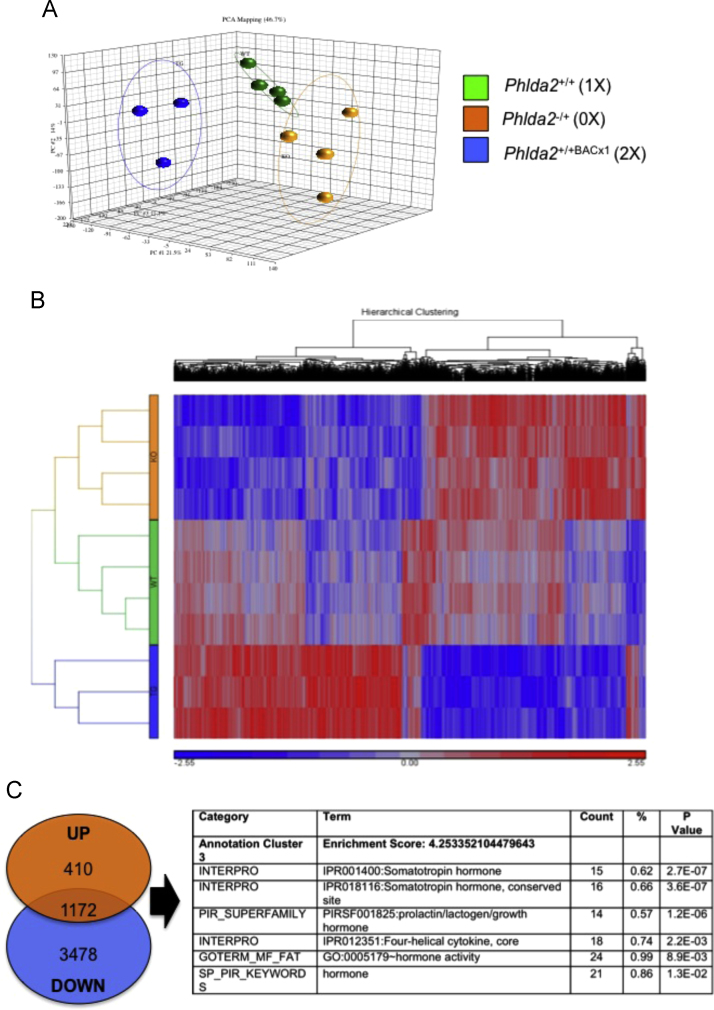
Microarray analysis identifies the transcriptomic signature of the spongiotrophoblast. A. Three-dimensional principle components analysis plot clustering placental gene expression with genotypes. B. Heat map showing genes significantly altered in relations to changes in Phlda2 gene dosage. The colour represents the expression level of the gene. Red represents high expression, while green represents low expression. The expression levels are continuously mapped on the colour scale provided at the bottom of the figure. Phlda2−/+(0X) and Phlda2+/+BACx1(2X) placenta show a reciprocal pattern of expression. C. Enrichment for placental hormones after pathways analysis of genes significantly UP in Phlda2−/+(129)(0X) and significantly DOWN in Phlda2+/+BACx1(2X) placenta (p≤0.05) presumed to originate within the spongiotrophoblast. Supplemental Table 1 list the DAVID results and the UP DOWN annotated probe sets with a significant differences in gene expression at P≥0.05.